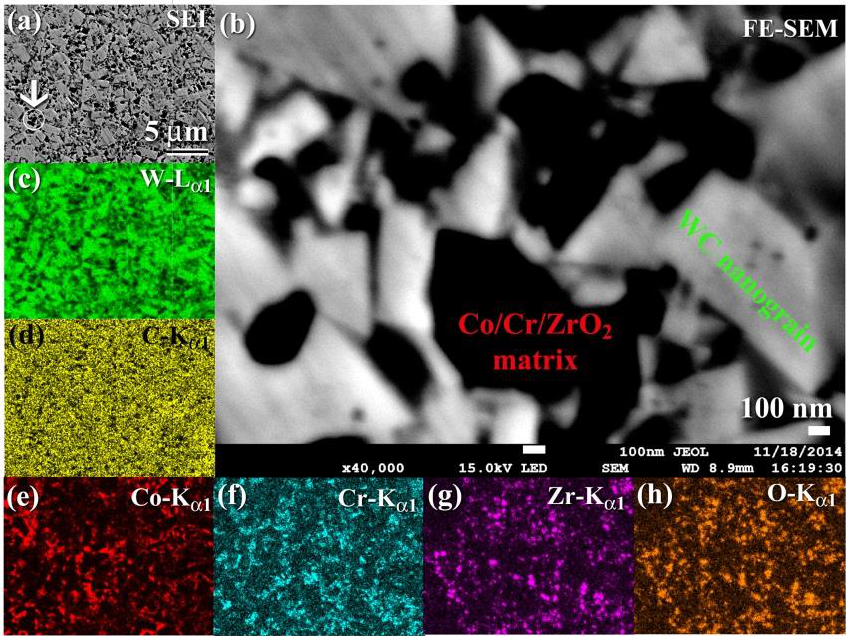
Figure 27. ( a ) FESEM micrograph of the cross-sectional view of as-ball milled nanocomposite 93(93- WC/7 wt. % (10Co/4Cr)) /7 wt. % ZrO 2 powders (50 h) and then consolidated at 1250 °C, using the SPS technique. The high-magnification (×40,000) for the zone indexed by a circular symbol shown in ( a ) is presented in ( b ). The X-ray elemental mapping corresponding to ( a ) are shown in the figure for ( c ) W-Lα 1 , ( d ) C-Kα 1 , ( e ) Co-Kα 1 , ( f ) Cr-Kα 1 , ( g ) Zr-Kα 1 , and ( h ) O-Kα 1 .